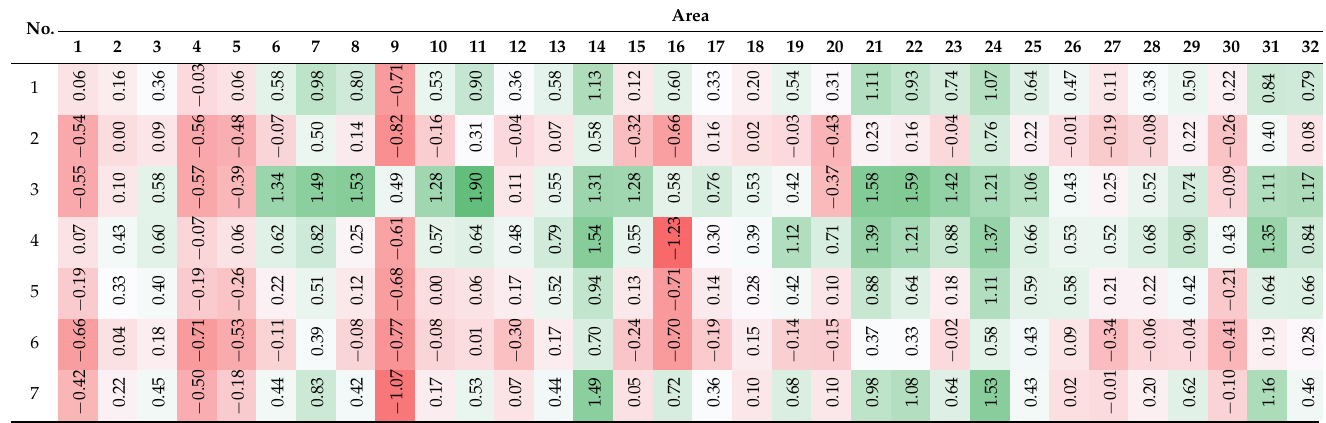
Table 4. Heat map of the arithmetic means from the answers given in the survey.